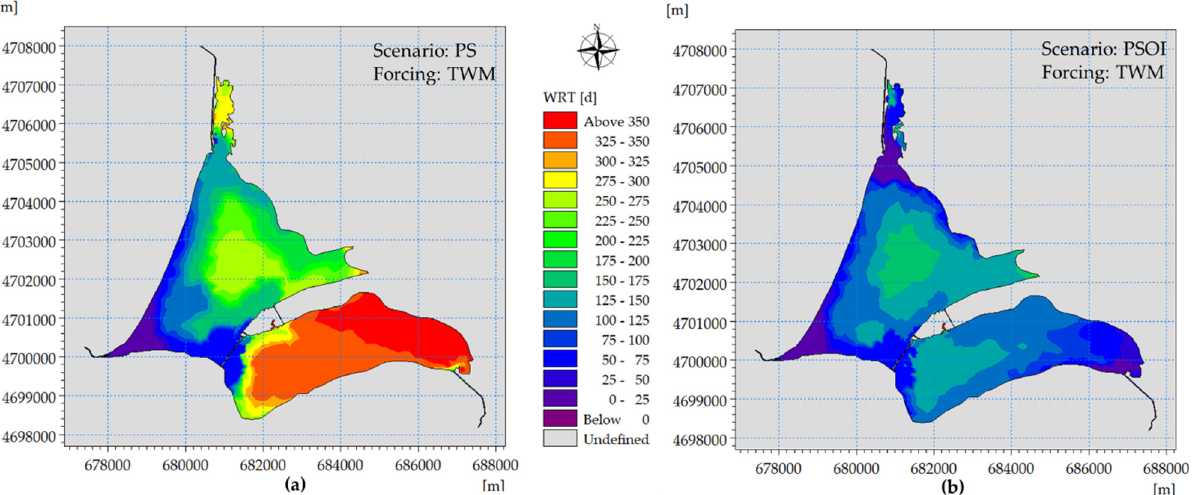
Figure 8. Distribution of WRT in the Orbetello Lagoon in the present scenario, with the grids and gates system installed in the lagoon inlets, present scenario (PS) ( a ); and with free, unobstructed inlets, scenario PSOI ( b ). Both cases are obtained under the full set of forcing mechanisms: astronomical tide, wind, and meteorological tide (code TWM).